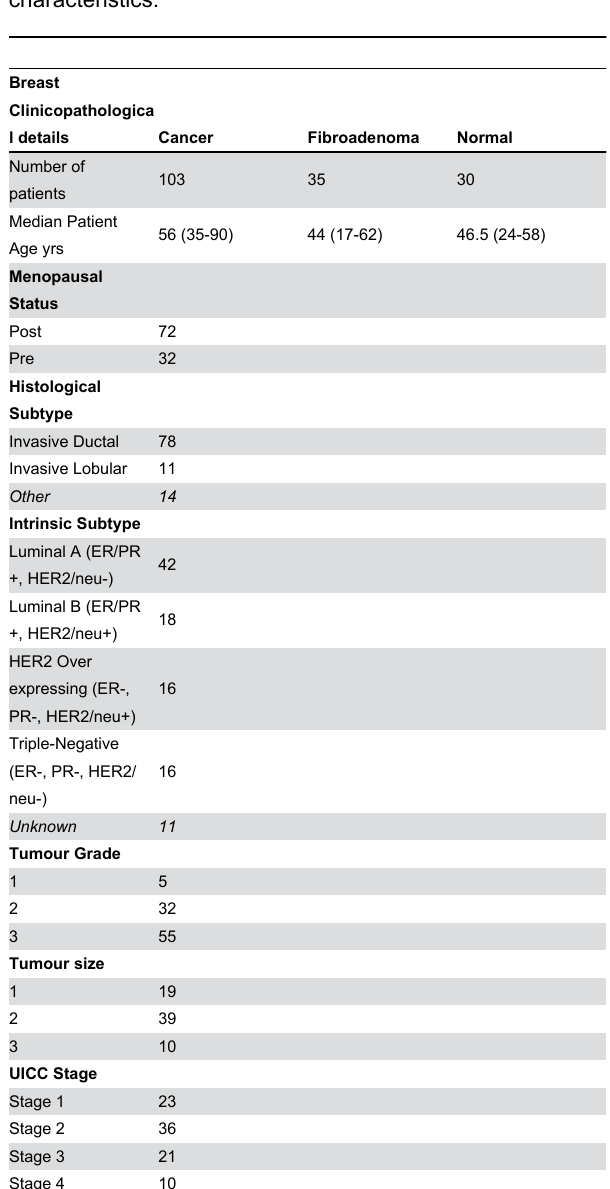
Table 1. Patient cohort and clinicopathological